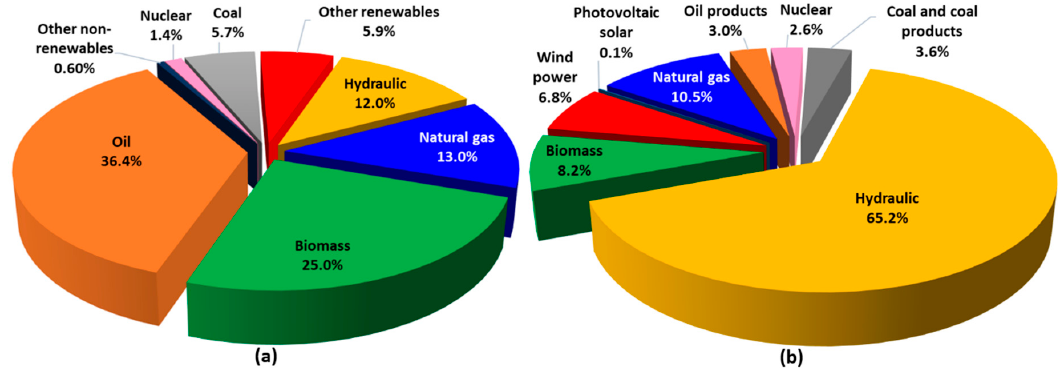
Figure 1. ( a ) Domestic Brazilian energy supply and ( b ) electrical matrix breakdown in 2017.